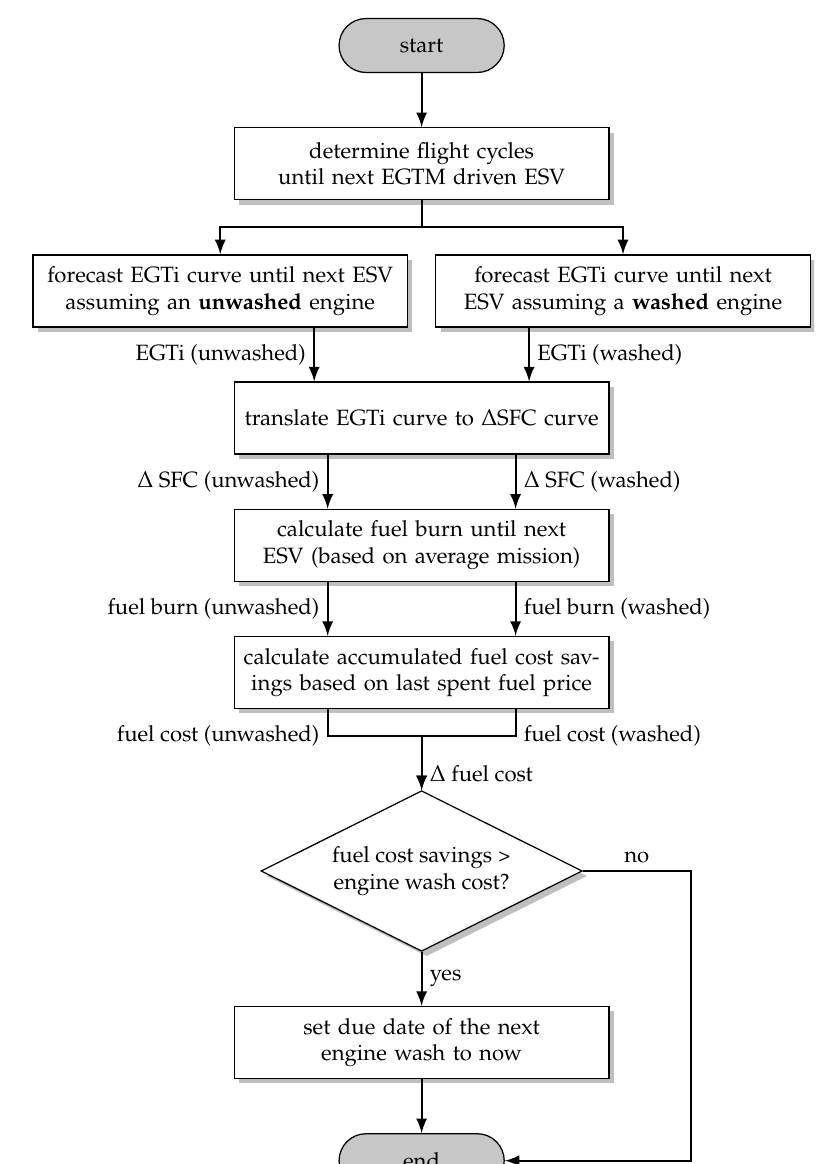
Figure 15. Decision making algorithm for triggering fuel cost optimized EW